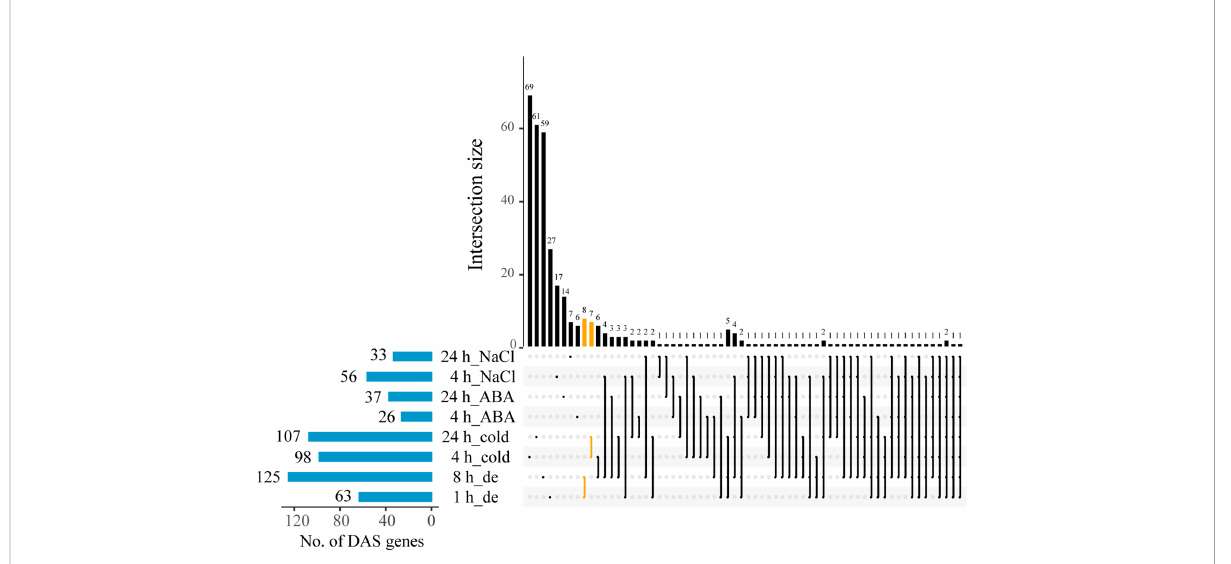
FIGURE 2 The numbers of differentially alternative splicing (DAS) genes between control and treatments with dehydration, cold, ABA, and NaCl at two different time points in B .